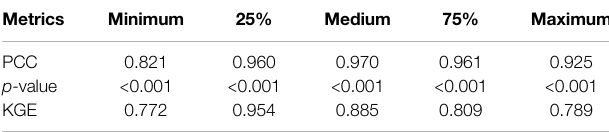
TABLE 5 | Correlation and fi tting of the annual TP in different percentiles between urban and non-urban regions of the YDM during 1992 – 2020.